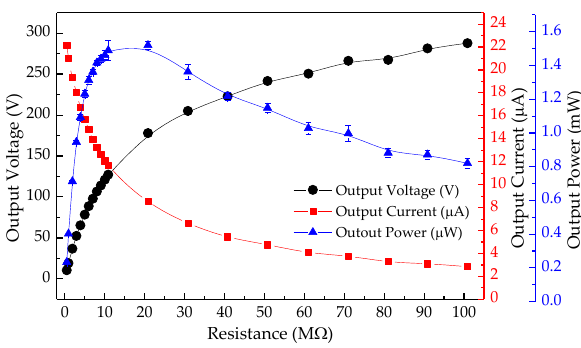
Figure 8. Electrical output parameters of TEHs across resistive loads at 4 mm gap width.